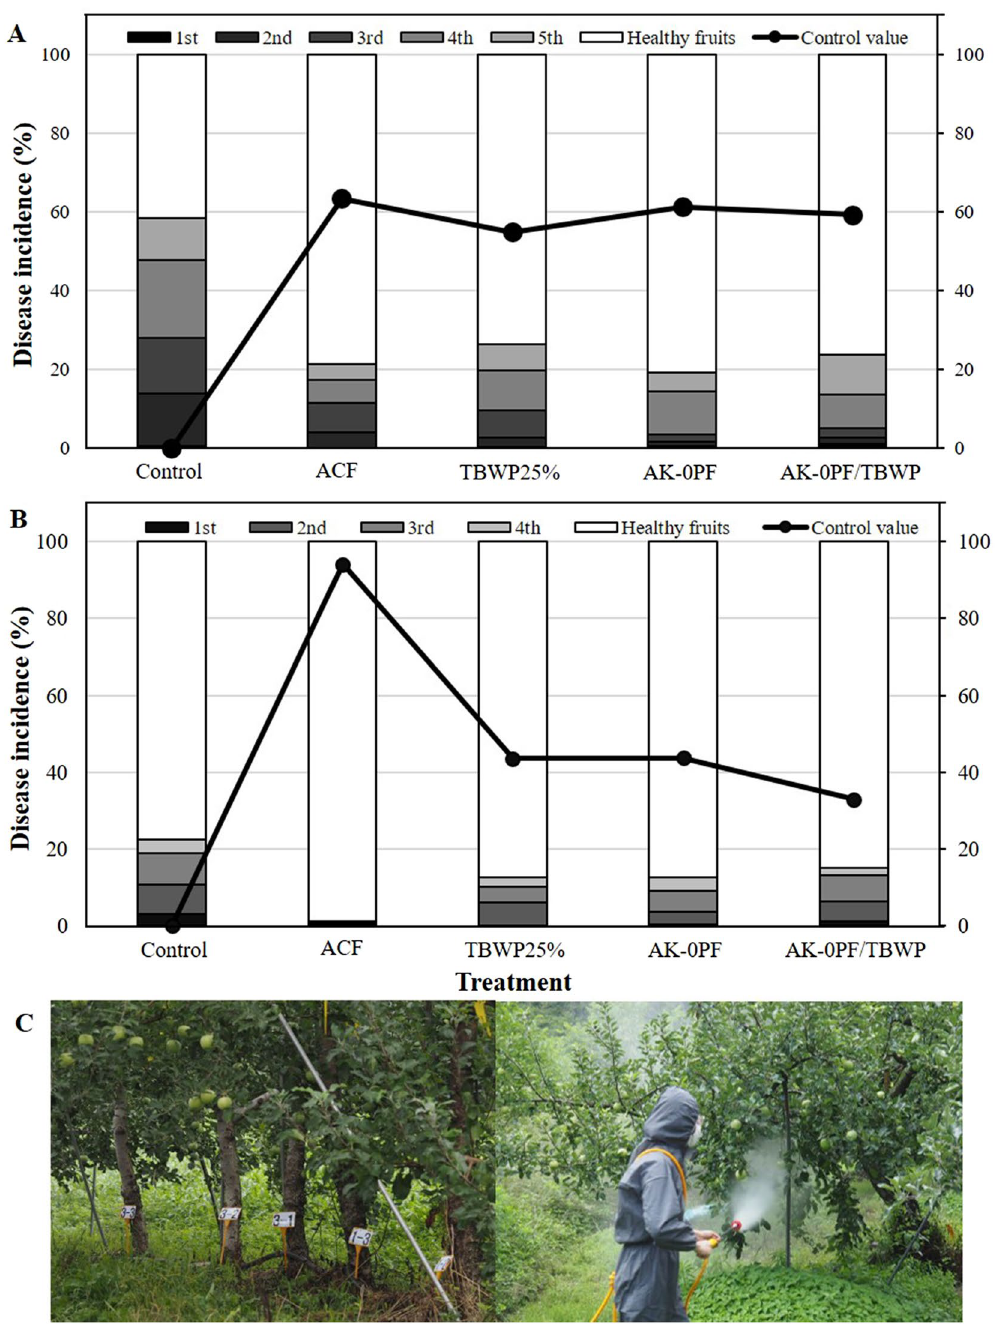
Figure 2. Effect of AK-0 product formulation and chemical fungicide application against bitter rot caused by Colletotrichum gloeosporioides on apple orchards (under field conditions) in Yecheon ( A ) and Mungyeong ( B ) in Gyeongbuk Province, Korea. ( C ) Representative photographs of the apple orchard showing the application of AK-0PF (100-fold) during the period from July 2019 to October 2019 to control apple bitter rot. A total of nine times applications was performed by the foliar spray method using an electric power sprayer. Each treatment contained three replicates (plants) in the experiment. Results were compared using the least significant difference (LSD) test ‘R’, with P < 0.01. The diseased fruits were harvested five and four times, in Yecheon and Mungyeong, respectively, to record the incidence (%). Control values (disease control %) are expressed along with the data. Control: plant treated with water, ACF: plants treated with agricultural chemical fungicides (Table S1), TBWP: plants treated with tebuconazole 25% WP (wettable powder), AK-0PF: AK-0 product formulation, AK-0PF/TBWP: plants treated with AK-0PF or TBWP as an alternative spray every week. The total number of diseased fruits harvested corresponding to 100% were 492, 649, 788, 1353, and 1087 for control,